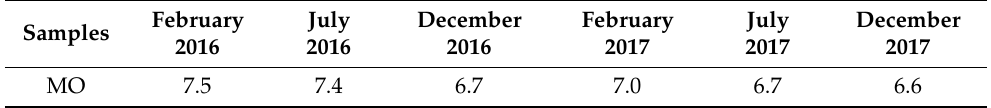
Table 3. The organoleptic characteristics of the monovarietal olive oil.